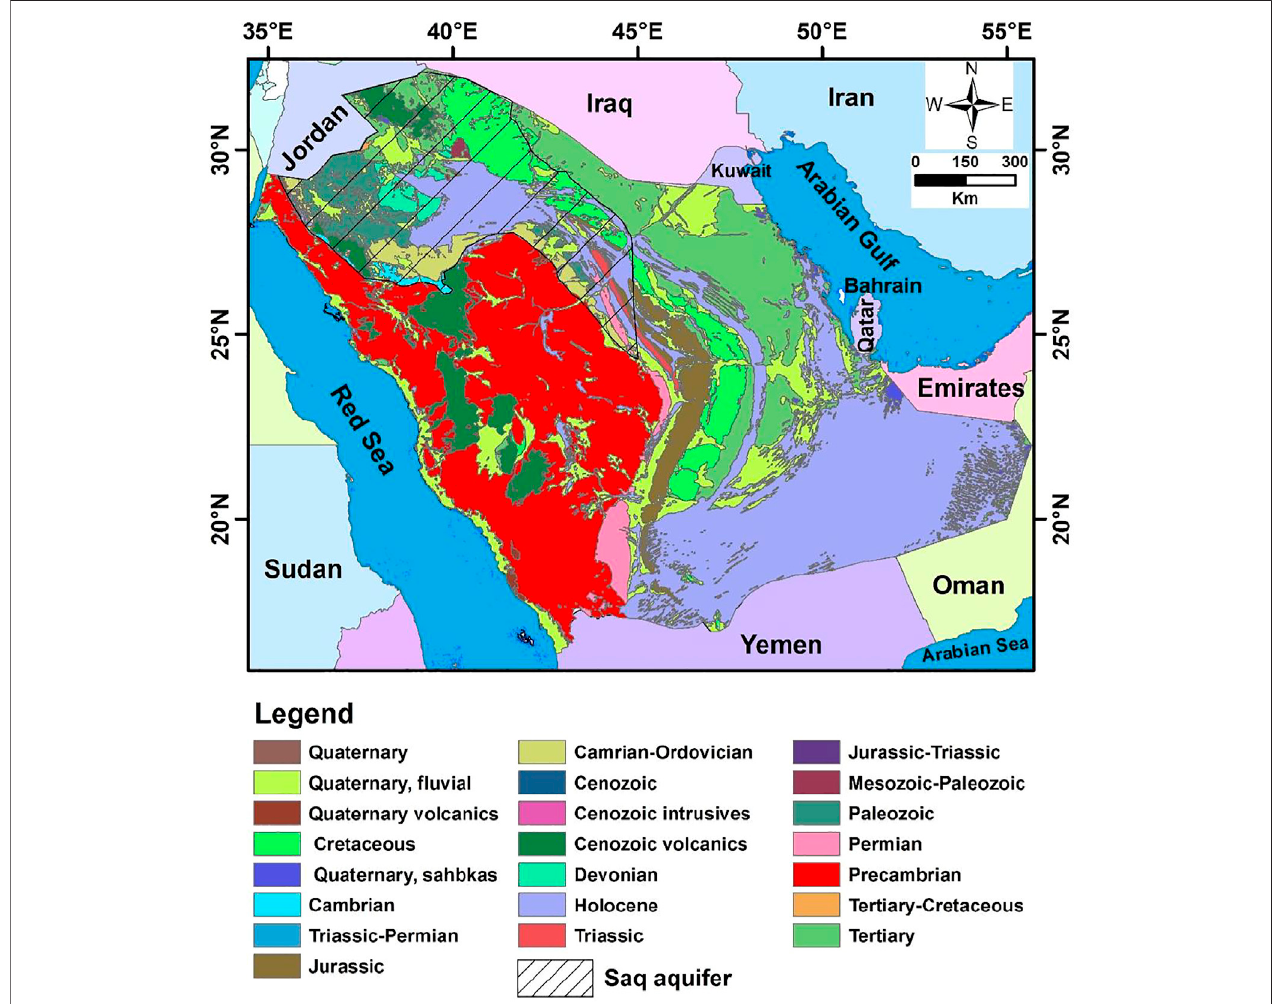
FIGURE 1 | Saudi Arabia ’ s geological map. The aerial distribution of the Saq aquifer is also shown.